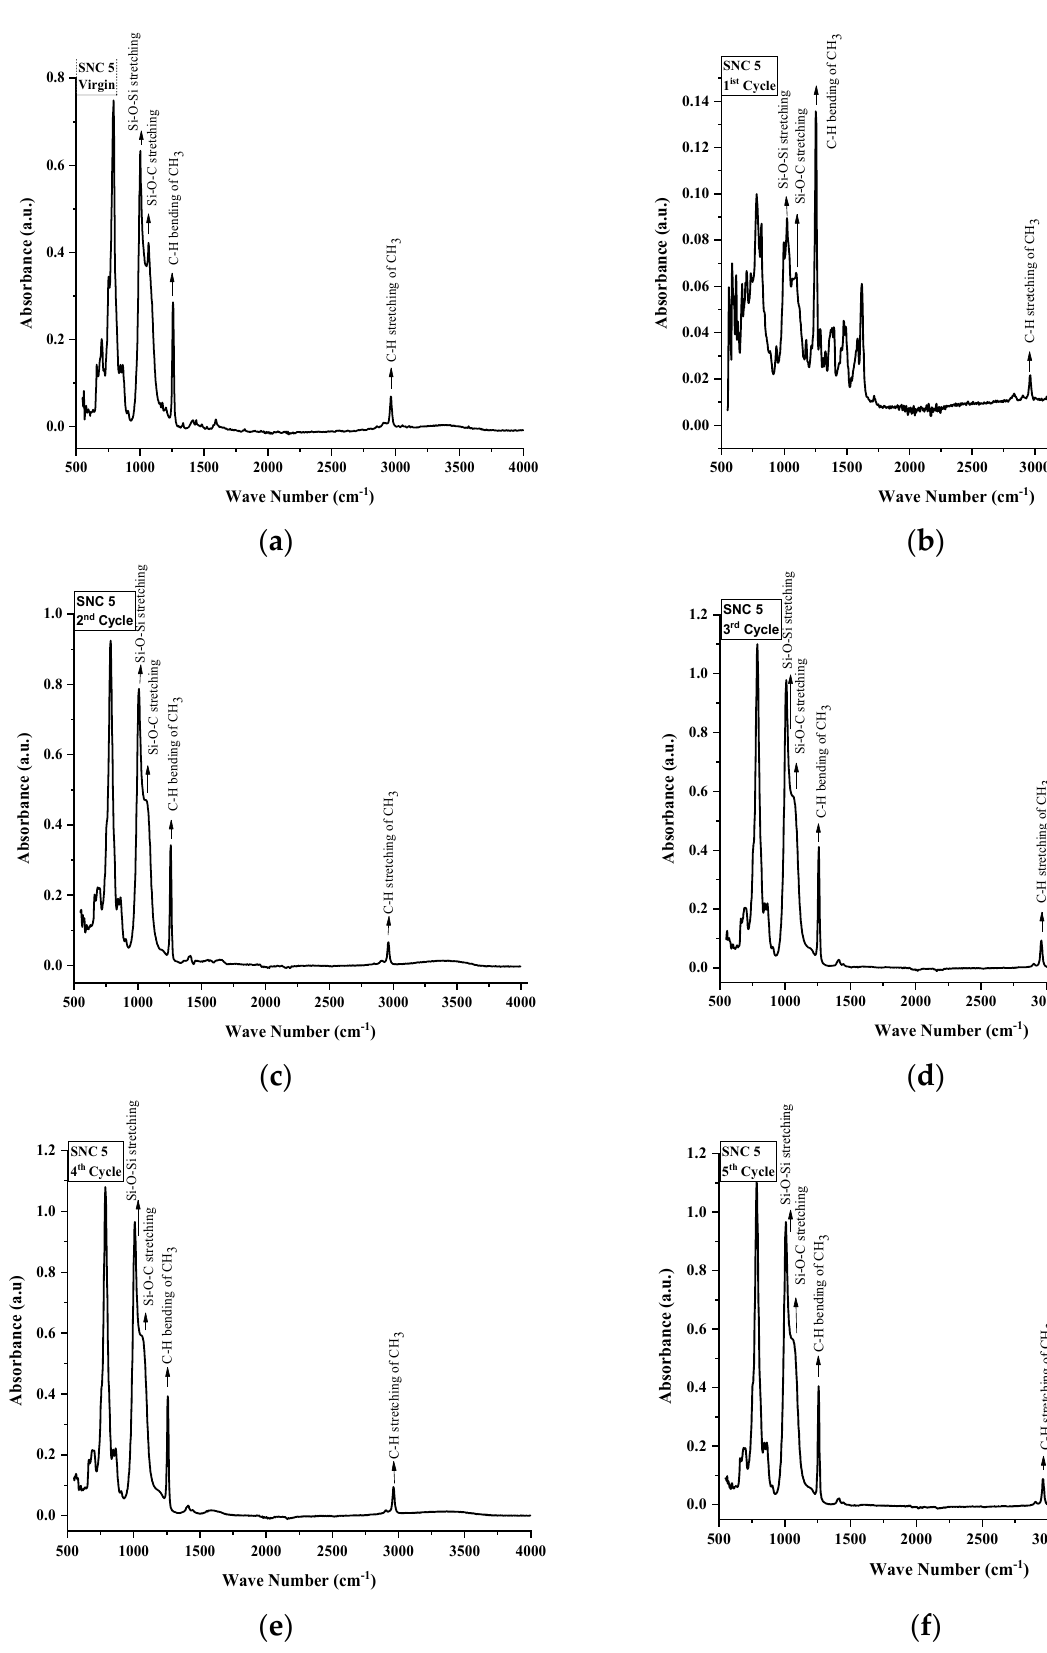
Figure 15 FTIR images of SNC : ( a ) virgin; ( b ) after 200 h. ( c ) after 400 h; ( d ) after 600 h; ( e ) after 800 h; ( f ) after 1000 h.